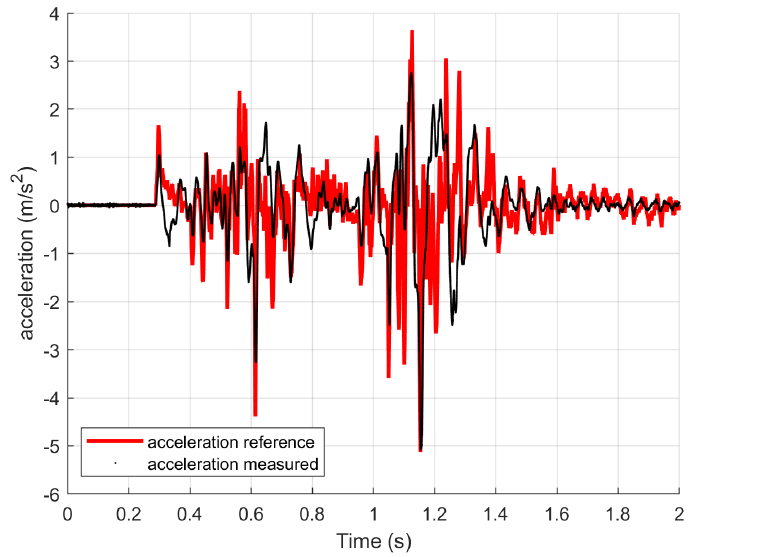
Figure 10. Comparison of the acceleration reference collected from the hand unit on the Samsung plant (red) and the iterative learning result